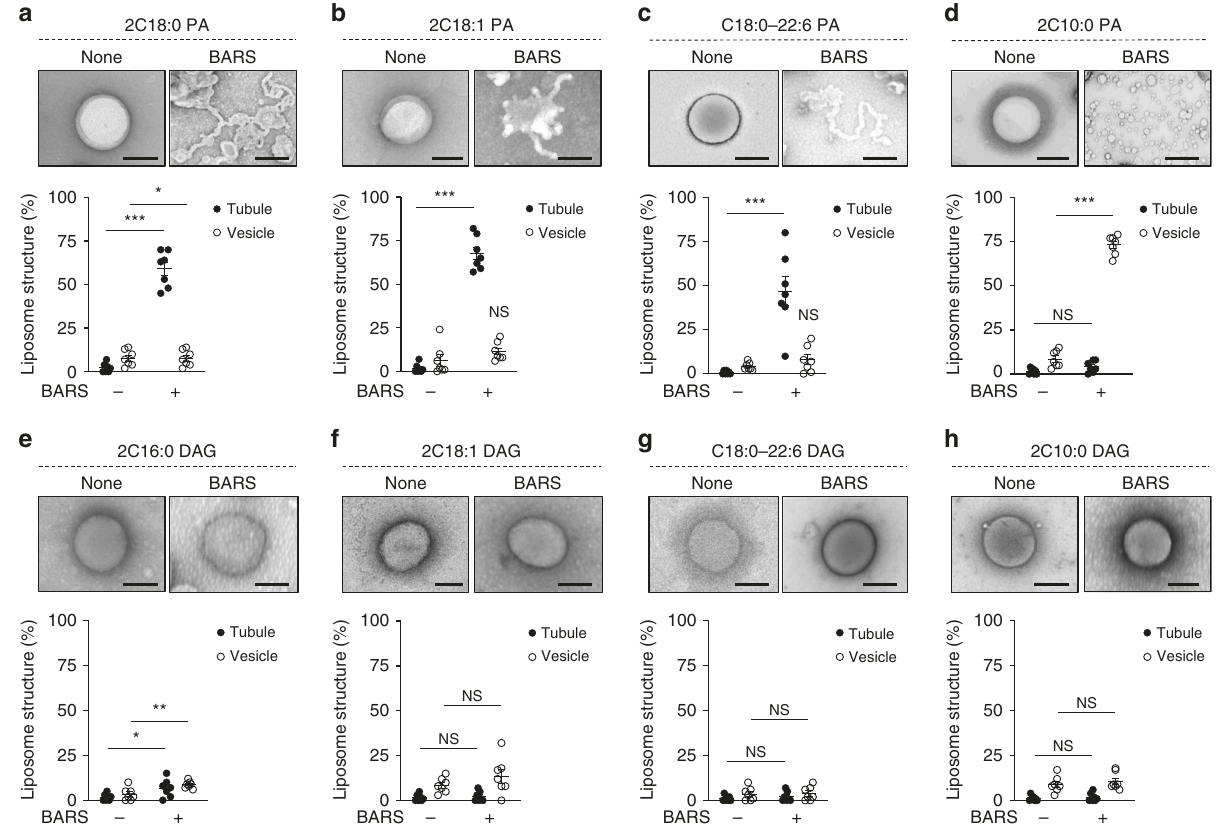
Fig. 9 Short phosphatidic acid (PA) promotes vesiculation by Brefeldin-A ADP-ribosylated substrate (BARS). Quantitative data are shown as mean ± s.e.m. Signi fi cance was tested using the two-tailed Student ’ s t test, * P < 0.05, ** P < 0.01, *** P < 0.0001, NS P > 0.05. a – d Liposomes with different forms of PA as indicated were incubated with recombinant BARS and then examined by electron microscopy (EM). Representative images are shown above, bar = 250 nm. Quantitation of liposome tubulation and vesiculation is shown below; n = 4 independent experiments. e – h Liposomes with different forms of diacylglycerol as indicated were incubated with recombinant BARS and then examined by EM. Representative images are shown above, bar = 250 nm. Quantitation of liposome tubulation and vesiculation is shown below; n = 4 independent experiments. Source data are provided as a Source Data fi